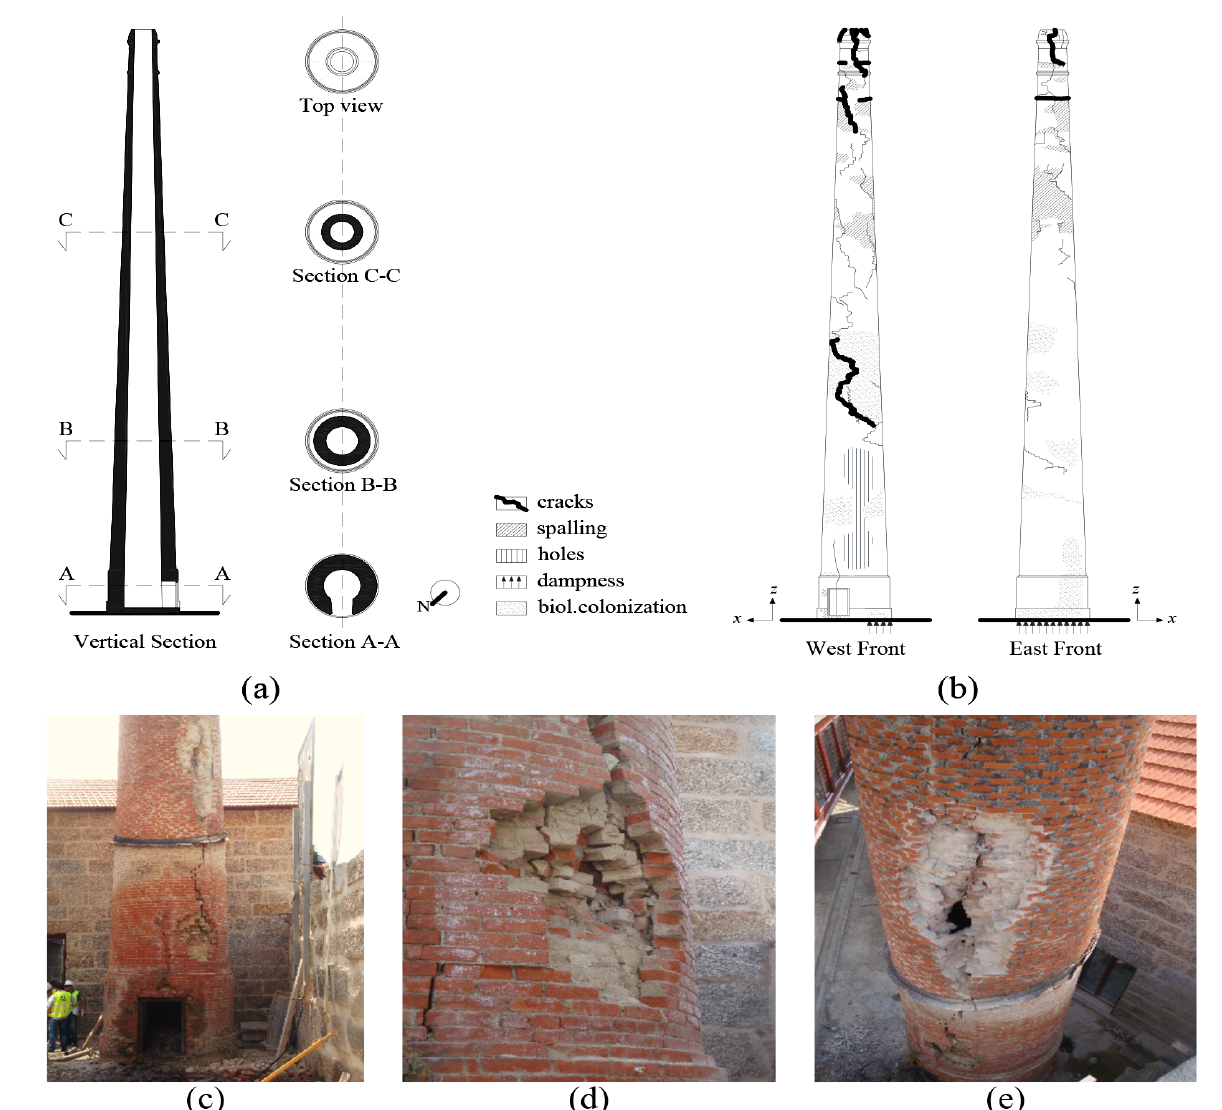
Figure 2. Masonry chimney: (a) geometrical features; (b) damage survey; (c) , (d) and (e) photographic survey of the openings caused by the